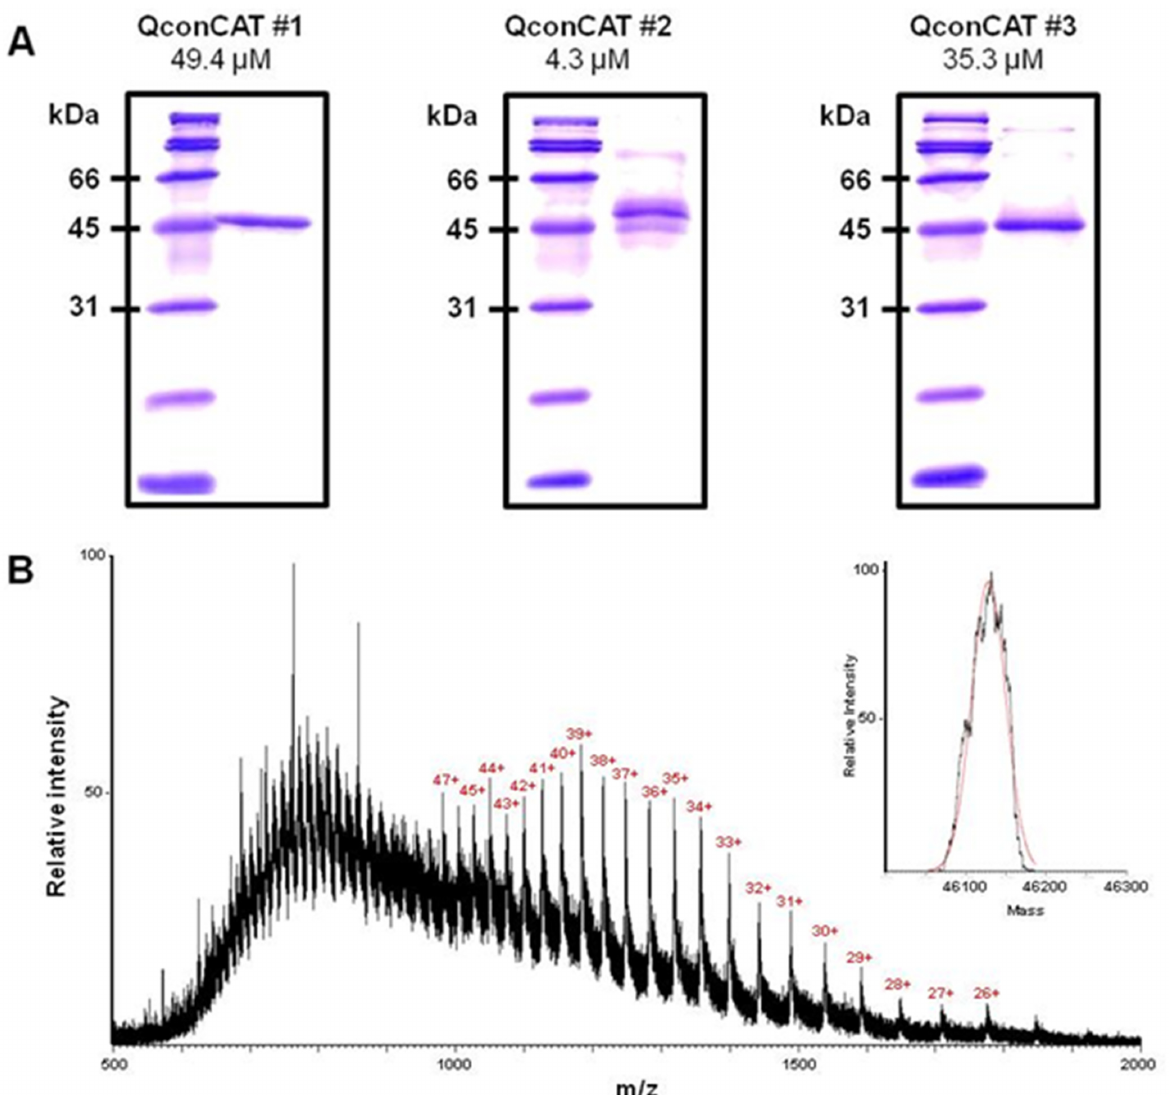
Fig 1. Purity and size of QconCATs. ( A ) Purified QconCATs (30 pmol of QconCAT#1, 22 pmol of QconCAT#2, and 25 pmol of QconCAT#3) were separated on 10% SDS-PAGE and ImageJ software was used for estimation of purity. Purity was nearly 100% for QconCAT#1, (cid:1) 95% for QconCAT#2, and (cid:1) 97% for QconCAT#3. Protein concentrations were determined by DC Protein Assay. ( B ) Charge state masses were collected for all QconCATs (representative spectrum of QconCAT#1 shown) with an Agilent 6550 QTOF and deconvoluted with MagTran 1.0 (insert) to confirm protein mass was congruous with expected mass based on sequence. Observed mass of QconCAT#1 was 46126.7 Da (46125.6 Da theoretical), QconCAT#2 was 48931.2 Da (48929.7 Da theoretical), and QconCAT#3 was 43167.8 Da (43166.6 Da